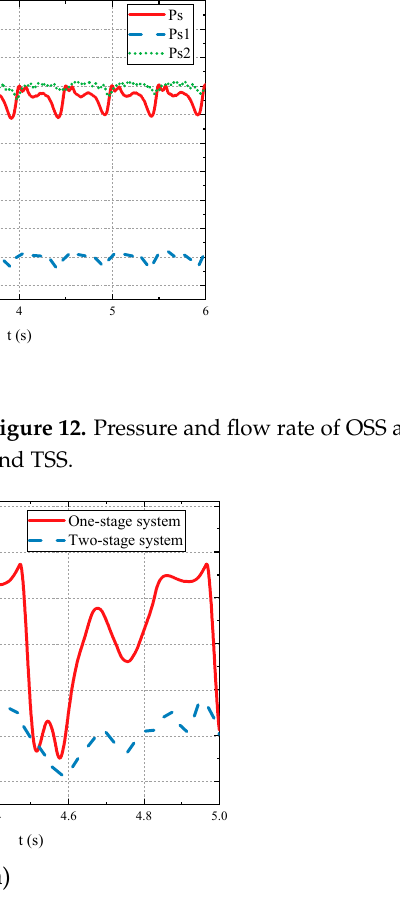
Figure 13. The instantaneous output power and energy consumption of OSS and TSS in a gait cycle: ( a ) The instantaneous output power of OSS and TSS; ( b ) Energy consumption of OSS and TSS.